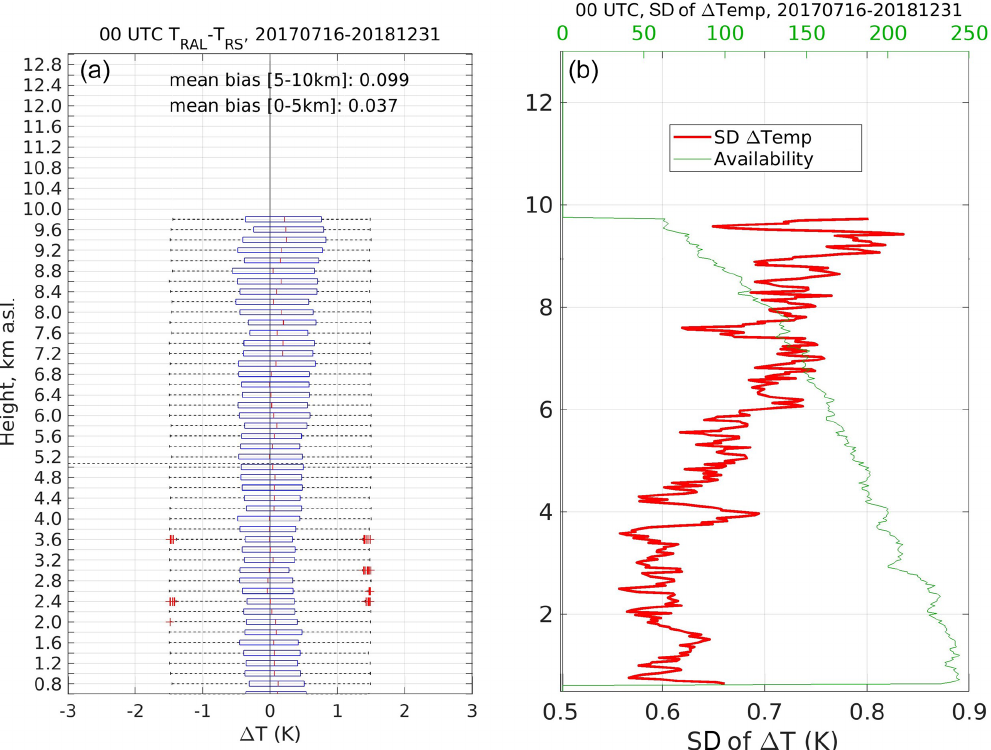
Figure 10. Nighttime bias and standard deviation (SD) of (cid:49)T over the period July 2017–December 2018. In (a) , on each box of 200m vertical span, the central mark indicates the median, and the left and right edges of the box indicate the 25th and 75th percentiles, respectively. The whiskers extend to the most extreme data points not considered outliers, and the outliers are plotted individually and shown by the “+” symbol. The thick red curve in the right panel shows the vertical profile of SD calculated over the altitude-decreasing number of (cid:49)T points (thin green).